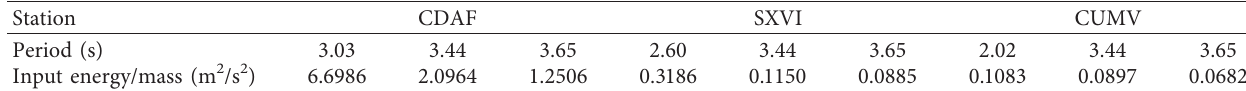
Table 14: Elastic input energy of interest: Mexico City earthquake of September 19, 1985.